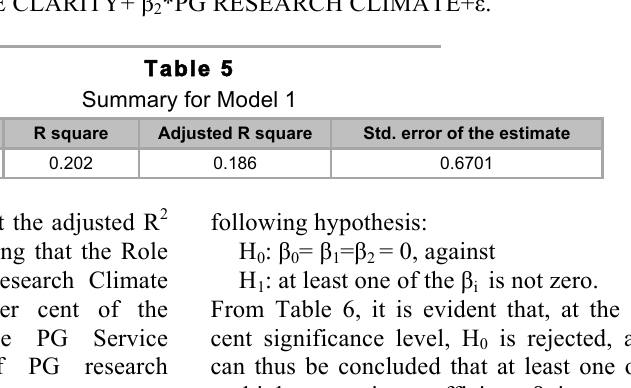
Table 5 reflects the summary results of Model 1 which was stated as: PG SERVICE